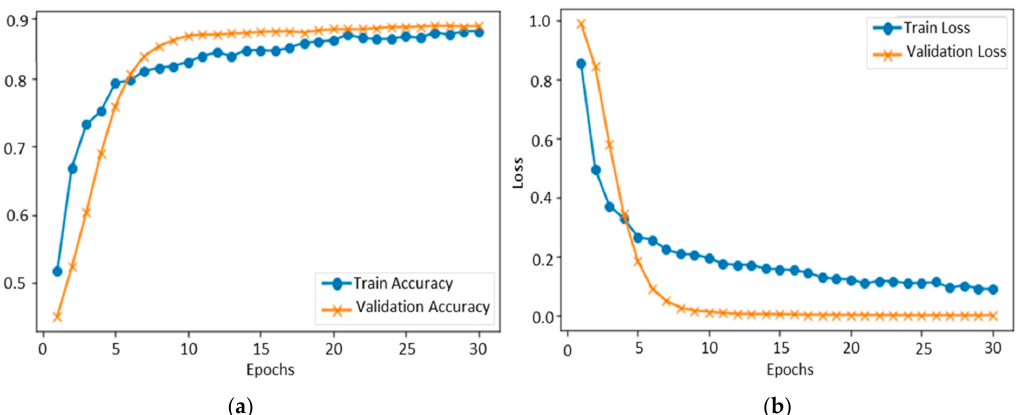
Figure 3. Training and validation of the proposed model over FER-2013: ( a ) accuracy and ( b ) loss.